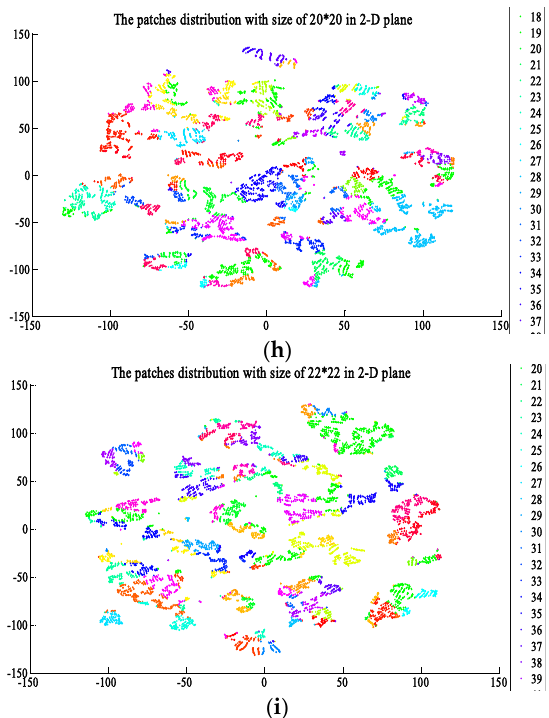
Figure 7. The different performances in 2-D plane of the patches with different sizes. The x and y axis represent the position coordinates. The performances of patches with sizes ( a ) size 6 × 6; ( b ) size 8 × 8; ( c ) size 10 × 10; ( d ) size 12 × 12; ( e ) size 14 × 14; ( f ) size 16 × 16; ( g ) size 18 × 18; ( h ) size 20 × 20; ( i ) size 22 × 22.